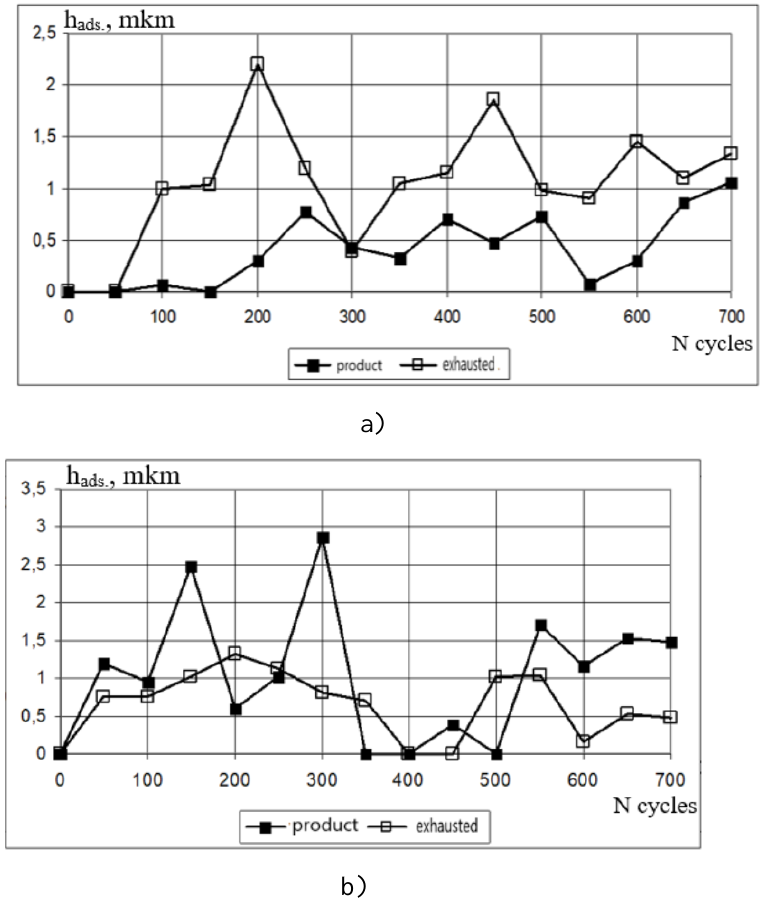
Fig. 1. Dynamics of formation of boundary adsorption layers (had.) with Mobil-1 oil at 20 0 C (a) and 120 0 C (b) at operating time